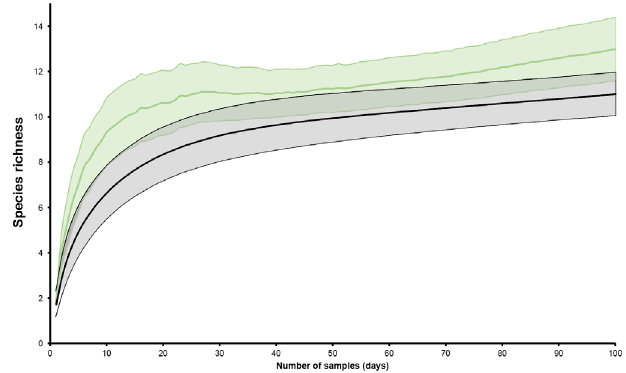
Figure 4. Rarefaction curve representing the species richness observed (black line) and the richness estimated by the Jackknife-1 estimator (green line) for 100 sampling days of pitfall traps in the open habitats at the Estação Ecológica de Santa Bárbara, state of São Paulo, Brazil. The grey and pale green areas represent the standard